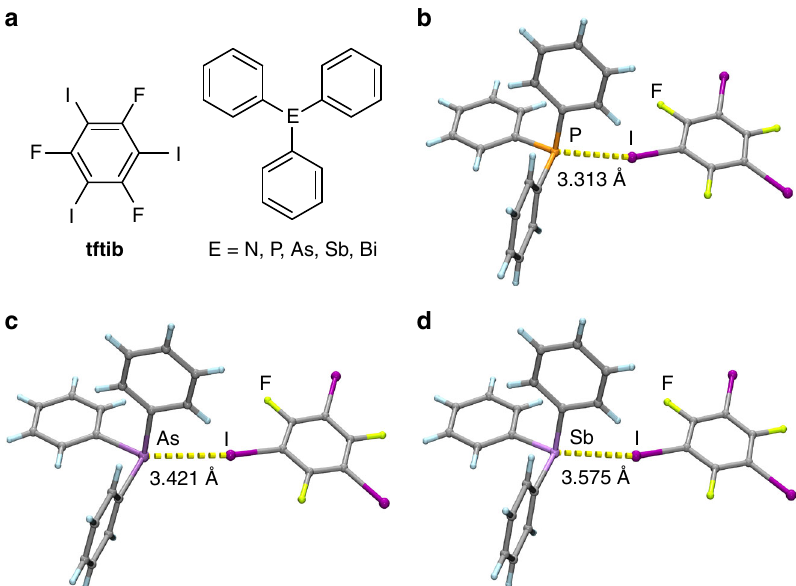
Fig. 1 Cocrystals with I···P, I···As, and I···Sb halogen bonds. a Schematic view of the herein explored halogen bond donor tftib and the acceptors NPh 3 , PPh 3 , AsPh 3 , SbPh 3 , and BiPh 3 . Structures of the halogen-bonded molecular assemblies in the cocrystals: b ( tftib )( PPh 3 ), c ( tftib )( AsPh 3 ), and d ( tftib )( SbPh 3 )